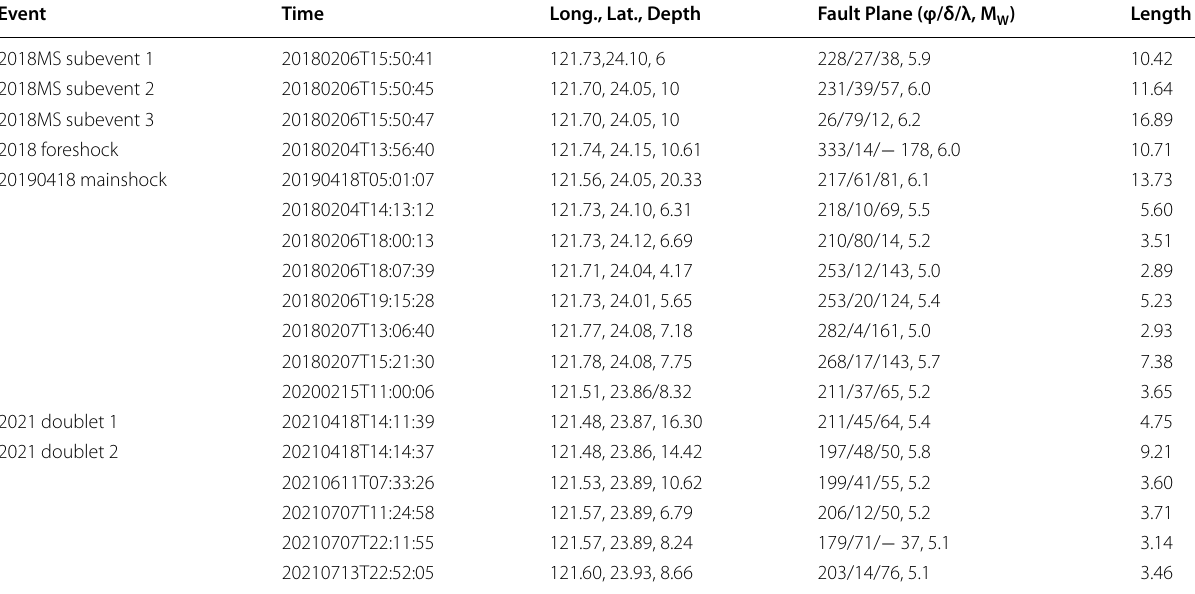
5.0 earthquakes W ≥